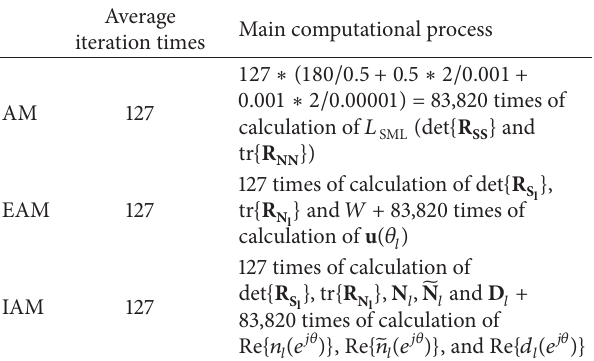
algorithm0.1320900850.1320900900.132090095 L M S algorithmUse of IAM Figure 1: Numerical instability in EAM and stability in IAM crite- rion.